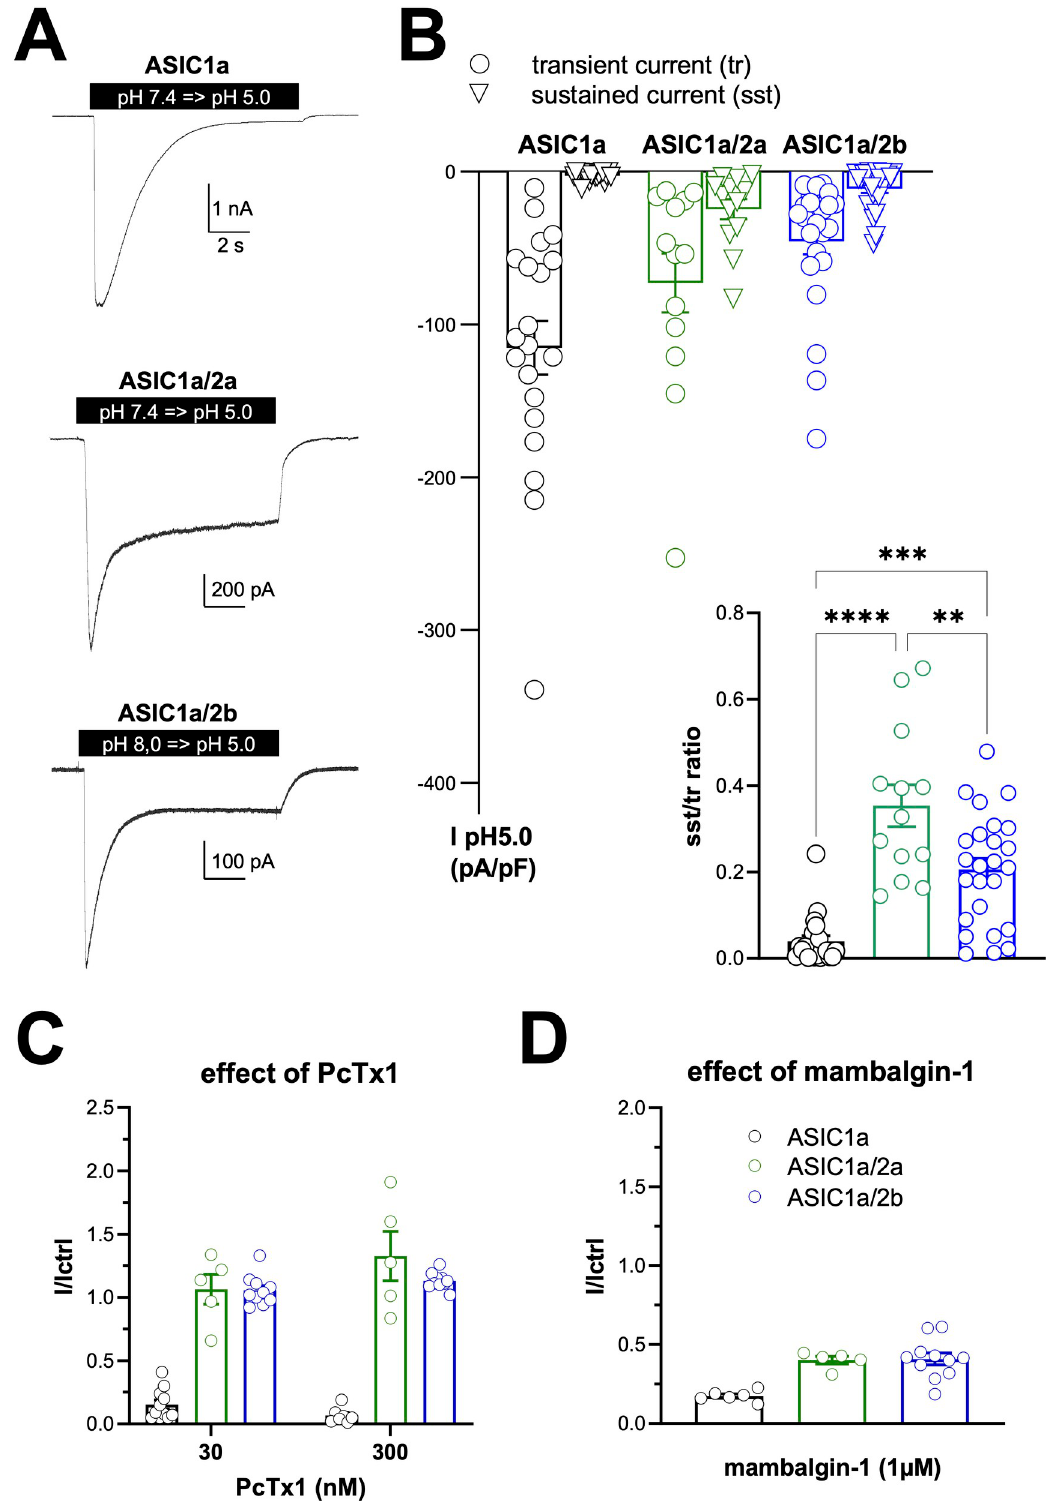
Fig 3. Effects of PcTx1 and mambalgin-1 on ASIC1a homomeric and heteromeric channels. A , Typical ASIC1a, ASIC1a/2a and ASIC1a/2b currents recorded at -50 mV from HEK293 transfected cells following extracellular acidification to pH5.0. B , Statistical analysis of the current densities recorded in A. Both the transient (tr) and sustained (sst) currents were measured, and the ratio sst/